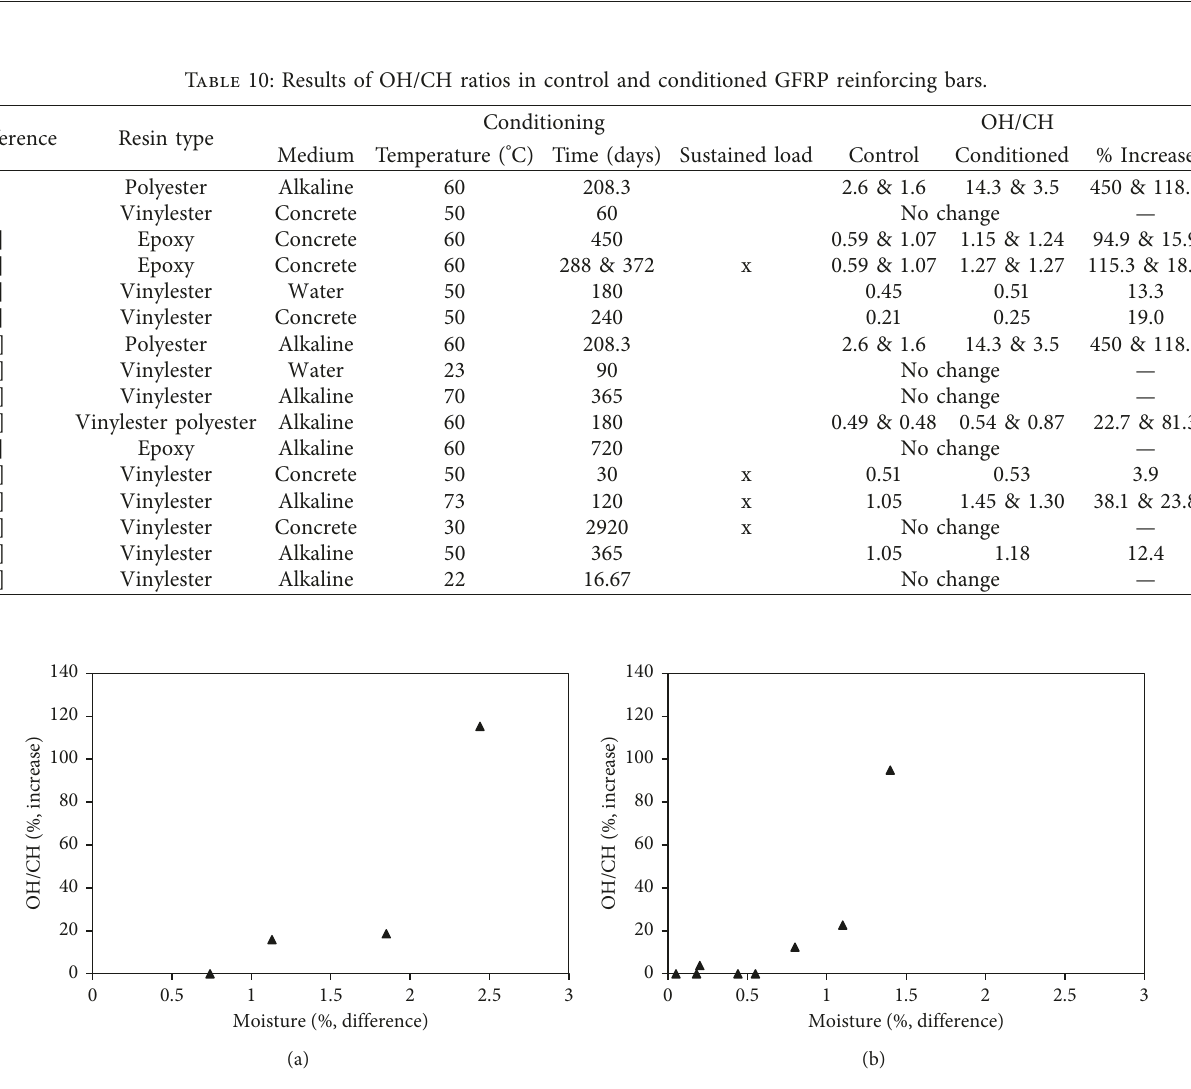
Figure 12: Correlation between OH/CH increase (%) and moisture uptake due to conditioning (%). (a) GFRP with epoxy matrix. (b) GFRP with vinylester